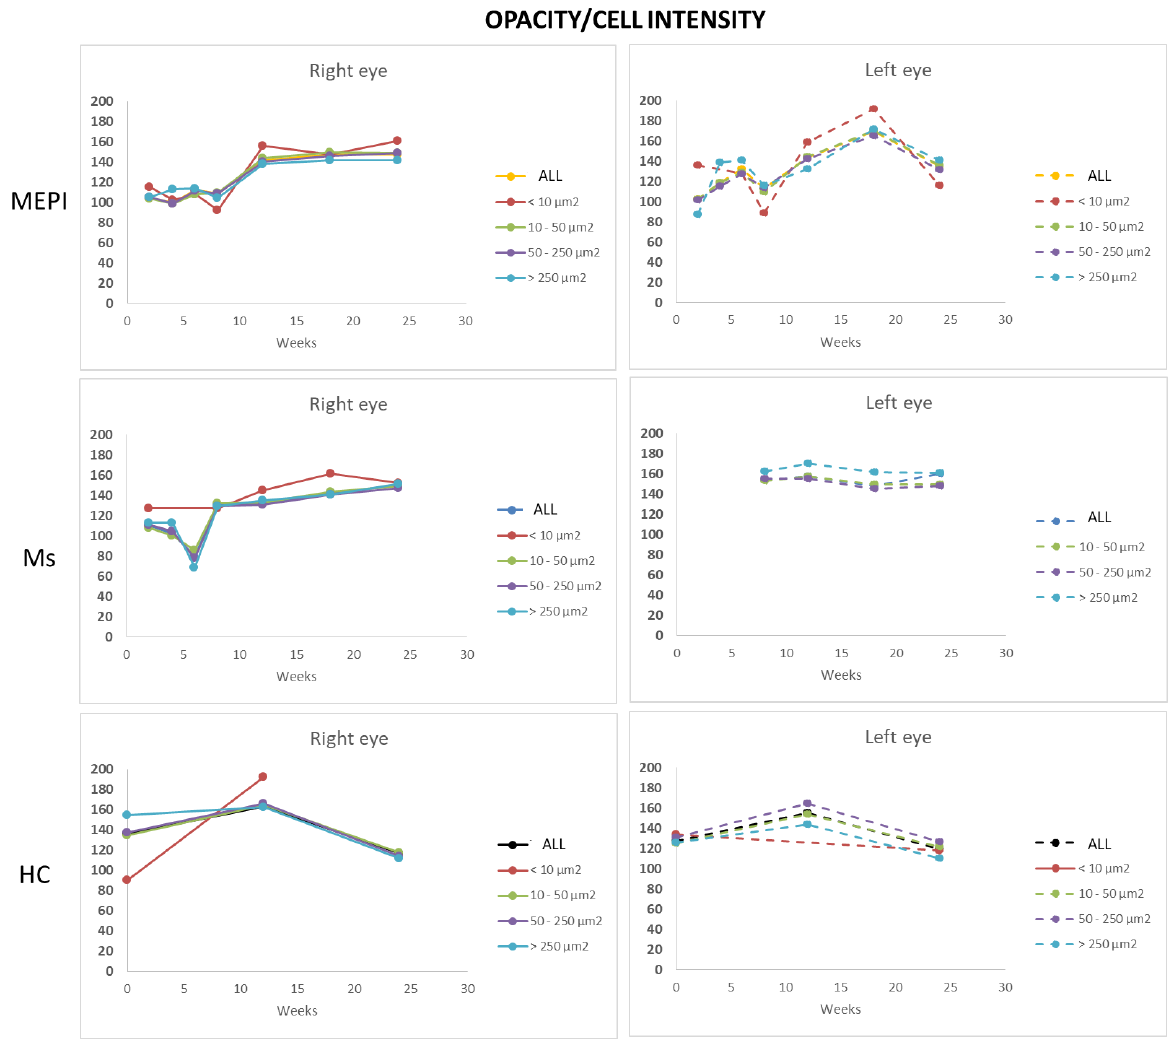
Figure 10. Mean intensity of opacities/cells based on size in both chronic glaucoma models and healthy controls. Abbrevia- tions: MEPI: model induced by sclerosing the episcleral veins; Ms: model induced by injecting microspheres into the anterior chamber; isolated cells: opacities < 10 microns 2 ; non-activated cells: 10–50 microns 2 ; activated cells: 50–250 microns 2 ; cell complexes: > 250 microns 2 . There were no statistically significant differences.